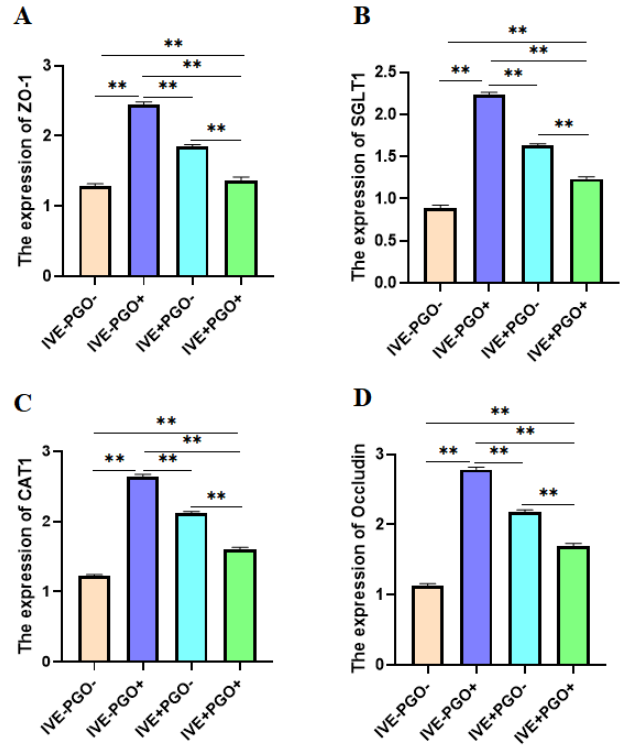
Figure 4. Effect of probiotics with added glucose oxidase (PGO) and Illicium verum extracts (IVE) on western blot of Zona Occludens 1 (ZO-1), Sodium/Glucose Cotransporter 1 (SGLT1), Cationic Amino Acid Transporter 1 (CAT1), and Occludin in jejunum of weaned piglets. Treatment 1 was fed with basal diet (IVE-PGO−), and treatments 2, 3, and 4 were fed the basal diet supplemented with 1000 mg/kg PGO (IVE-PGO+), 500 mg/kg IVE (IVE + PGO−), and 500 mg/kg IVE + 1000 mg/kg PGO (IVE + PGO+), respectively. ( A – D ) represents the expression on western blot of ZO-1, SGLT1, CAT1, and Occludin in jejunum. ** p < 0.01.